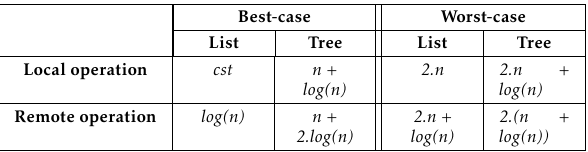
Table 1. Linear/Tree structurecomplexity time.